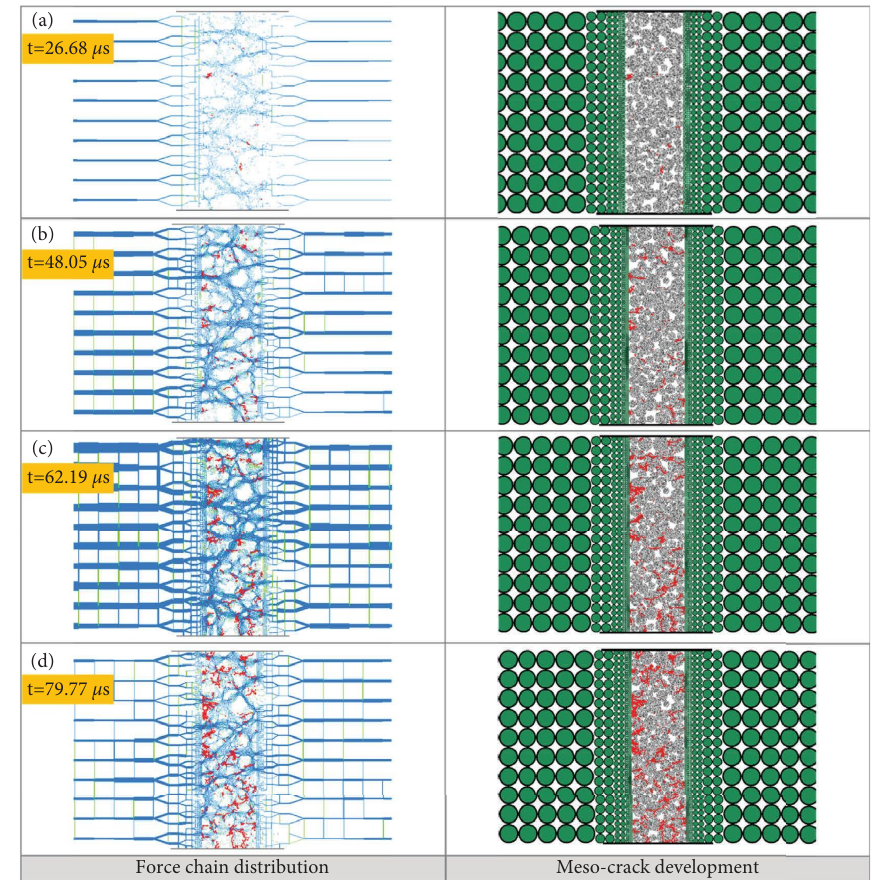
Figure 6: Force chain distribution and meso-crack development during the numerical compression test on the sand specimen. (a) t � 26.68 μ s, (b) t � 48.05 μ s, (c) t � 62.19 μ s, and (d) t � 79.77 μ s.